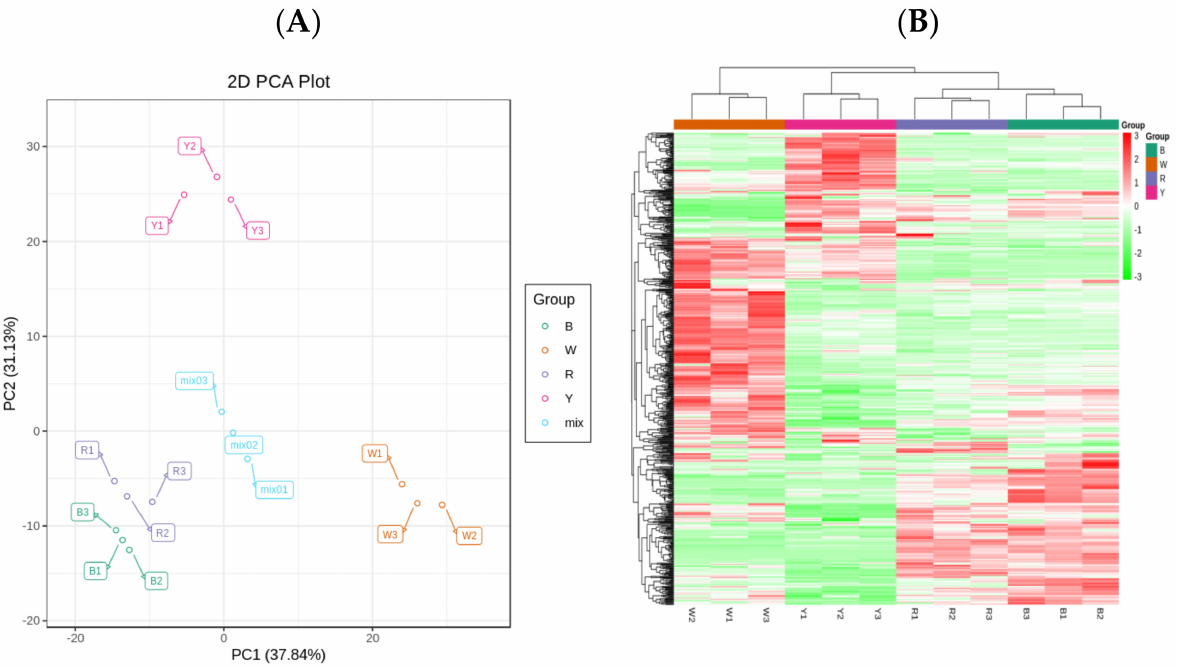
Figure 1. Analysis of metabolic among grains of four quinoa cultivars ( A ) total sample PCA; ( B ) clustering